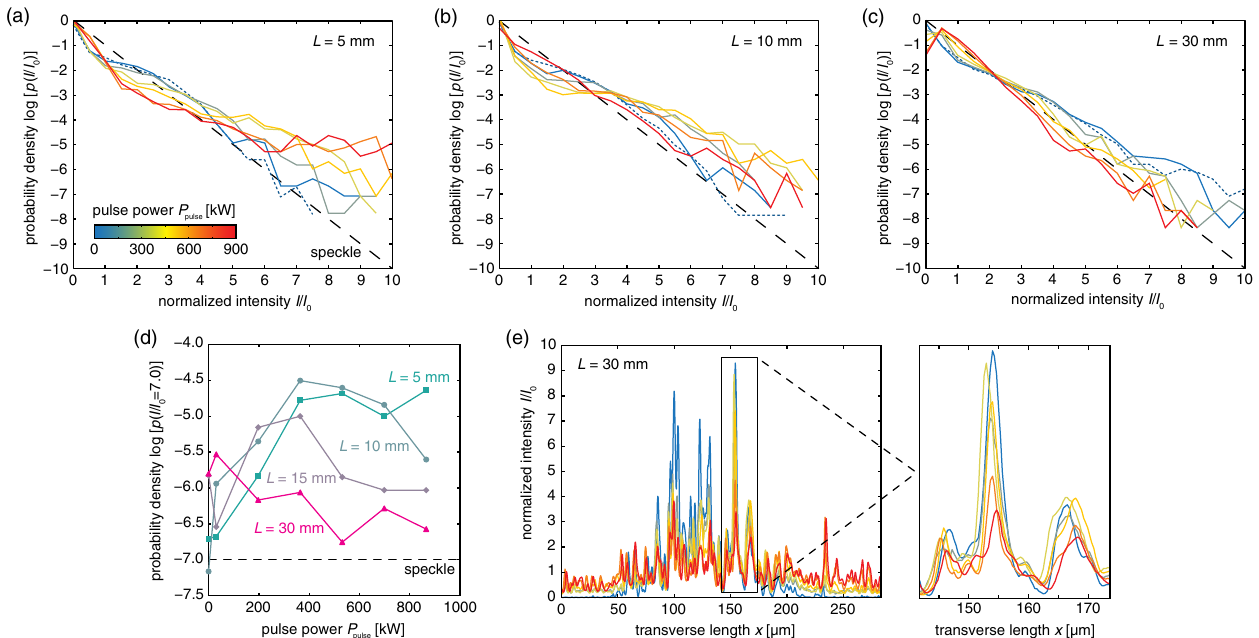
FIG. 10. Experimental results in the nonlinear regime. (a) – (c) Full histograms of the normalized intensity distribution as obtained at the rear facets of the samples for increasing pulse powers P and L ¼ 5 mm (a), L ¼ 10 mm (b), and L ¼ 30 mm (c). In each pulse case the respective linear measurement taken from Fig. 2(a) is depicted for reference (dark blue dashed curve). (a) While for low pulse powers the intensity distribution is specklelike, increasing the nonlinearity induces more extreme events due to self-focusing. (b) After an initial rise of extreme events, further increasing the pulse power leads to a regression. (c) The abundance of extreme events at low pulse powers is progressively suppressed as the pulse power increases, finally restoring a specklelike distribution. (d) Comparison of the probability density of a specific intensity I ¼ 7 . 0 I 0 for various sample lengths L . (e) Exemplary intensity profile as visible at the rear facet for L ¼ 30 mm. High pulse powers cause a thermalization of the intensity distribution by diminishing outstanding intensity peaks (see inset for a